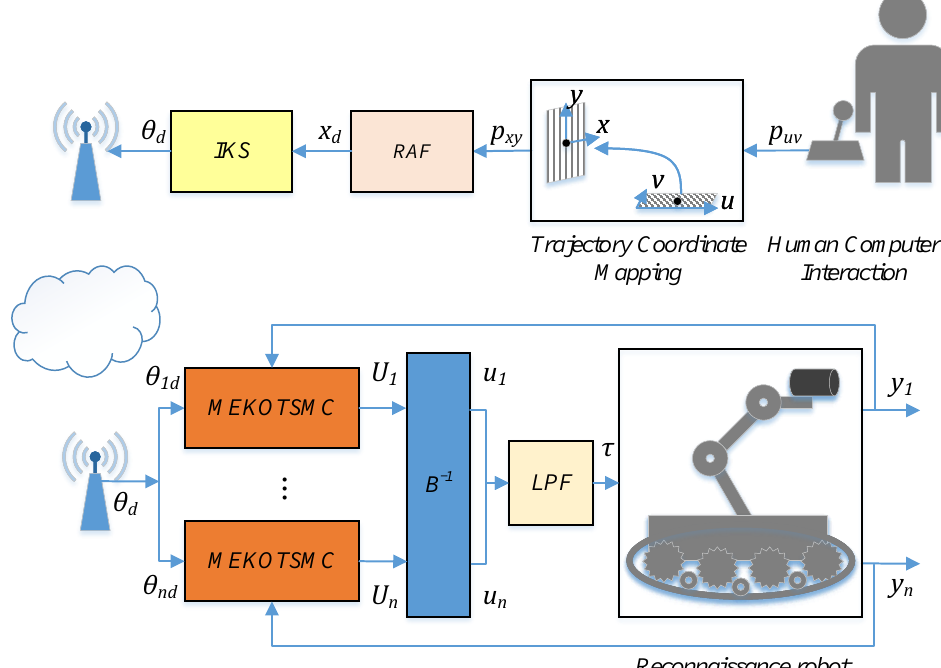
Figure 1. Block diagram of the proposed tele-aiming robot control